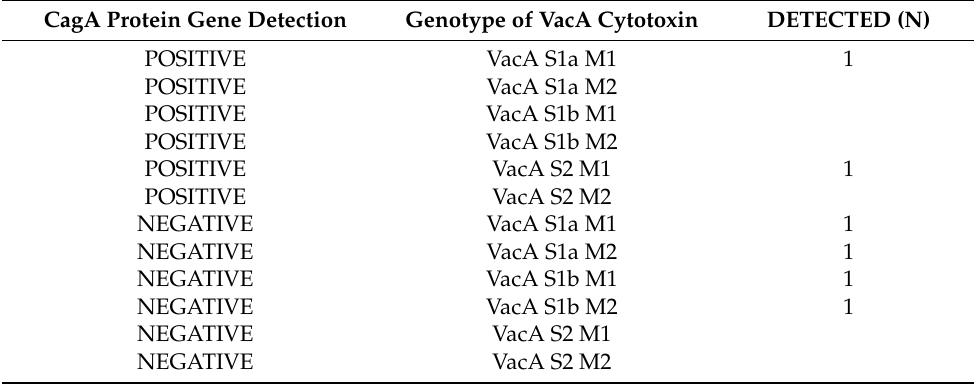
Table 7. Distribution of the different Helicobacter pylori genotypes in positive samples of the control group: (b) controls, n =